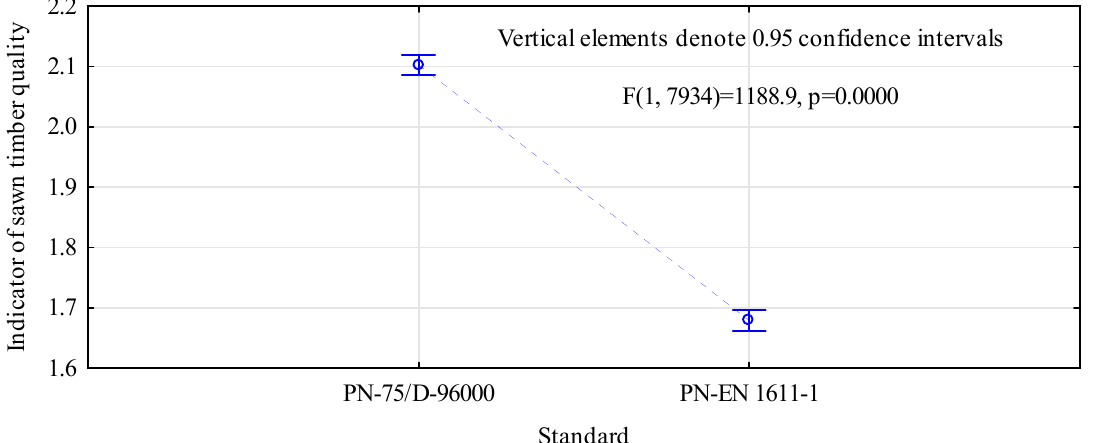
Figure 4. A comparison of average indicators of quality for sawn timber graded according to the Polish Standard (PN-75/D-96000) and the European Standard (PN-EN 1611-1).